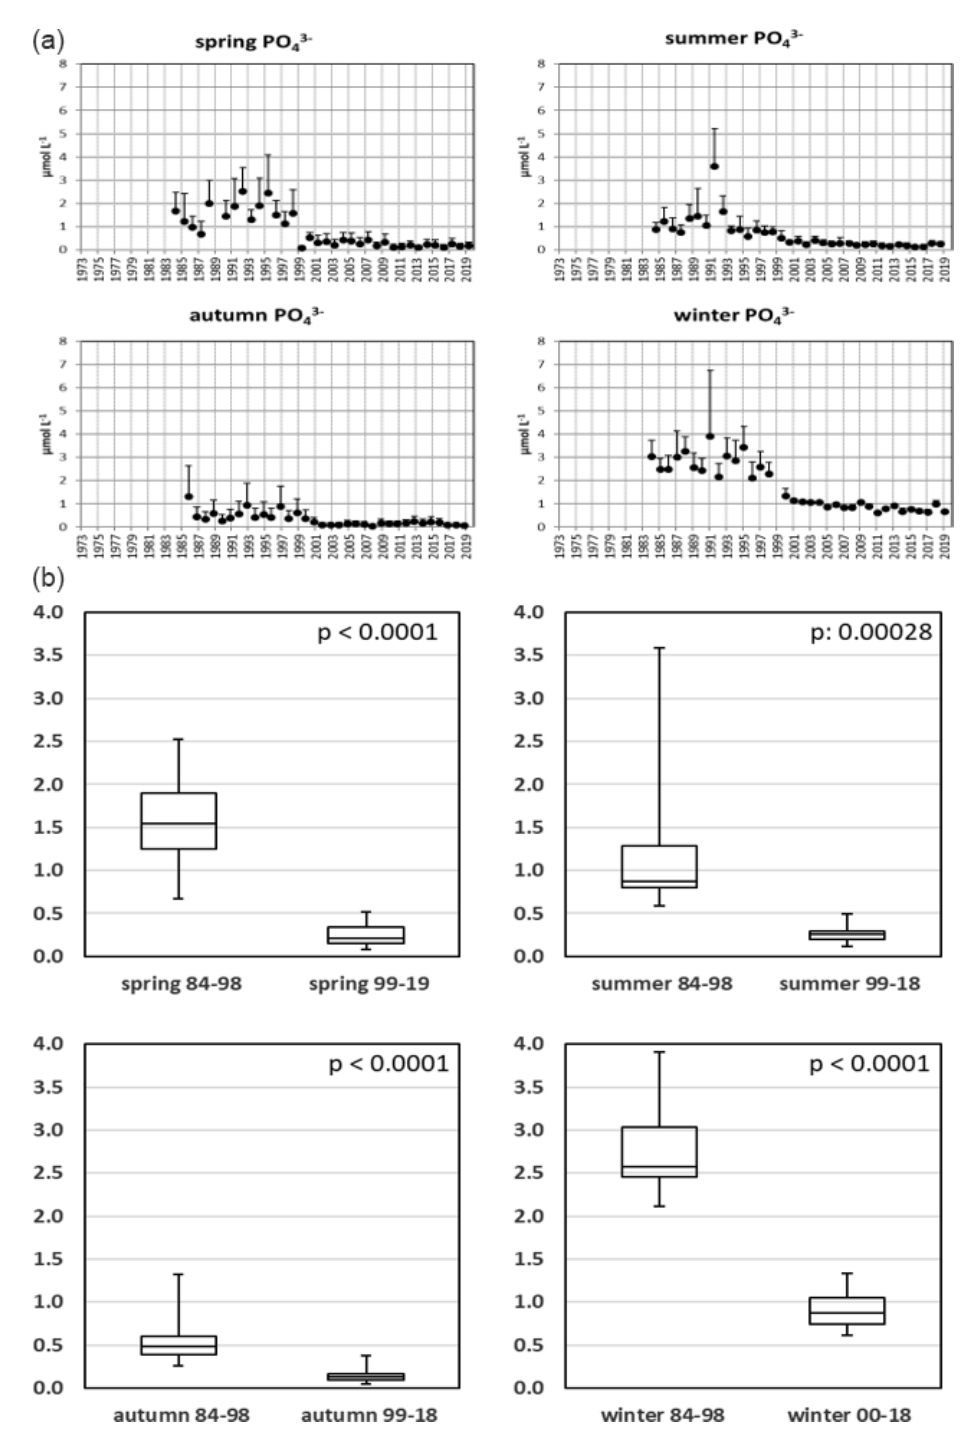
Figure 5. Development of SRP over the course of continuous measurements (1984–2019) within the Sylt Roads LTER time series. (a) Sea- sonal averages (December, January, February – winter; March, April, May – spring; June, July, August – summer; September, October, November – autumn) are displayed with standard error of the mean (SEM) as error bars. (b) Seasonal comparison of SRP concentrations (µmolL − 1 ) for high and low eutrophication periods. Box plots give median values, with quartiles 1 and 3 attached as boxes and min and max values shown as endpoints of the error bars. All data, including possible outliers, are shown in the graph. The p values of the respective t tests are given in the upper